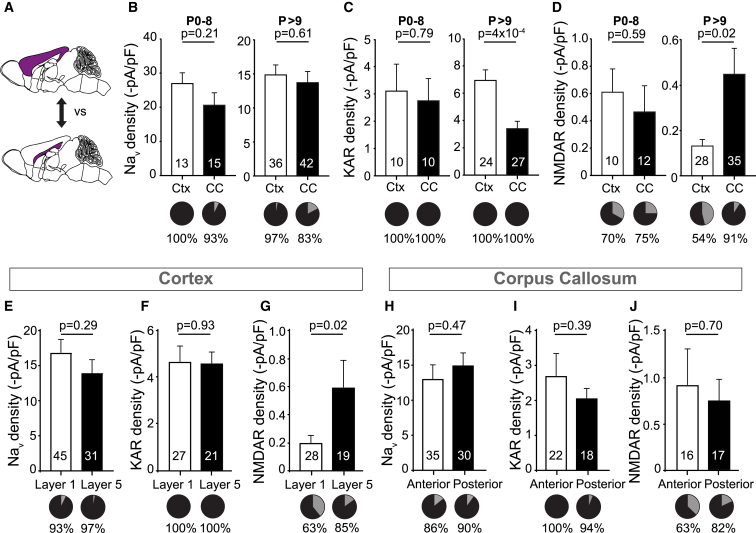
OPCs Become Regionally Diverse after the First Postnatal Week(A) OPCs were whole-cell patch-clamped in the corpus callosum or the cortex, as highlighted in the schematic diagram in purple.(B) NaV densities (bar graph) and the proportion of OPCs (pie charts) with detectable NaV currents (black) do not differ between the corpus callosum (CC) or the cortex (CTX), neither during the first postnatal week (p = 0.21, p = 0.94, χ2) nor thereafter (p = 0.61, p = 0.10, χ2).(C) AMPA/KAR densities did not differ between OPCs in the white matter (CC) or gray matter (CTX) at birth (p = 0.79, left) but became significantly different after P8 (p = 4 × 10−4). Throughout postnatal life, KA (30 μM) evoked currents in OPCs (pie charts underneath the bar graph, with [black] or without [gray] detectable evoked currents).(D) NMDAR densities and the proportion of OPCs with detectable NMDA (60 μM)-evoked currents (pie charts) were not different between OPCs in the CC or the CTX at birth (p = 0.59, p = 0.83, χ2) but became significantly different after P8 (p = 0.02, p = 1.7x10−3, χ2), with reduced NMDA-evoked currents in OPCs in the CTX.(E and F) Neither NaV (E) nor KAR (F) densities nor the proportion of cells with detectable NaV (p = 0.1, χ2) (E) or KA-evoked currents (p > 0.99, χ2) (F) differed between layer 1 and layer 5 of the CTX.(G) NMDAR densities were higher in layer 5 of the CTX compared with layer 1, but the proportion of OPCs with detectable NMDA-evoked currents did not differ between the two layers (p = 0.1, χ2).(H–J) There was no difference detected between the anterior or posterior CC in receptor densities or the proportion of cells responding to (H) NaV (p = 0.88, χ2), (I) KAR (p = 0.88, χ2), and (J) NMDAR (p = 0.37, χ2).Numbers shown on bar graphs represent cell numbers from 5–20 animals. Data are shown ± SEM. The p values are from Student’s t tests.